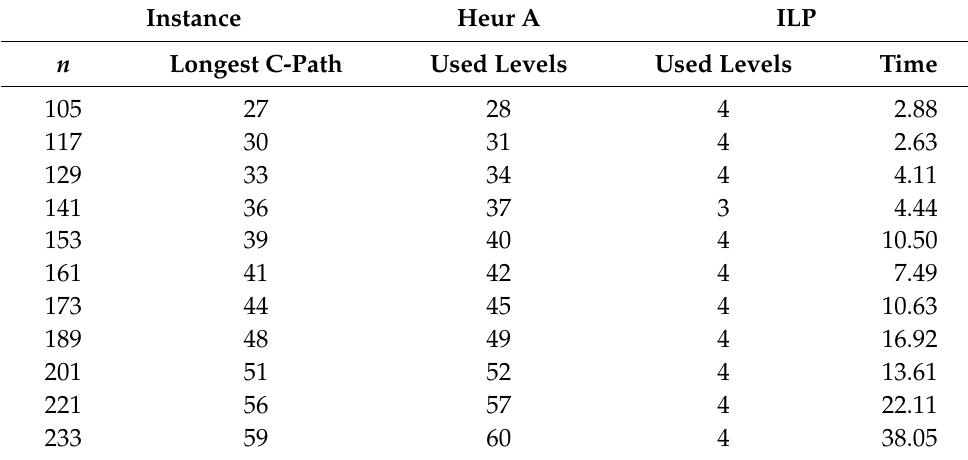
Table 3. Experimental results of ILP and Heuristic A on ad hoc instances. Instance Heur A ILP n Longest C-Path Used Levels Used